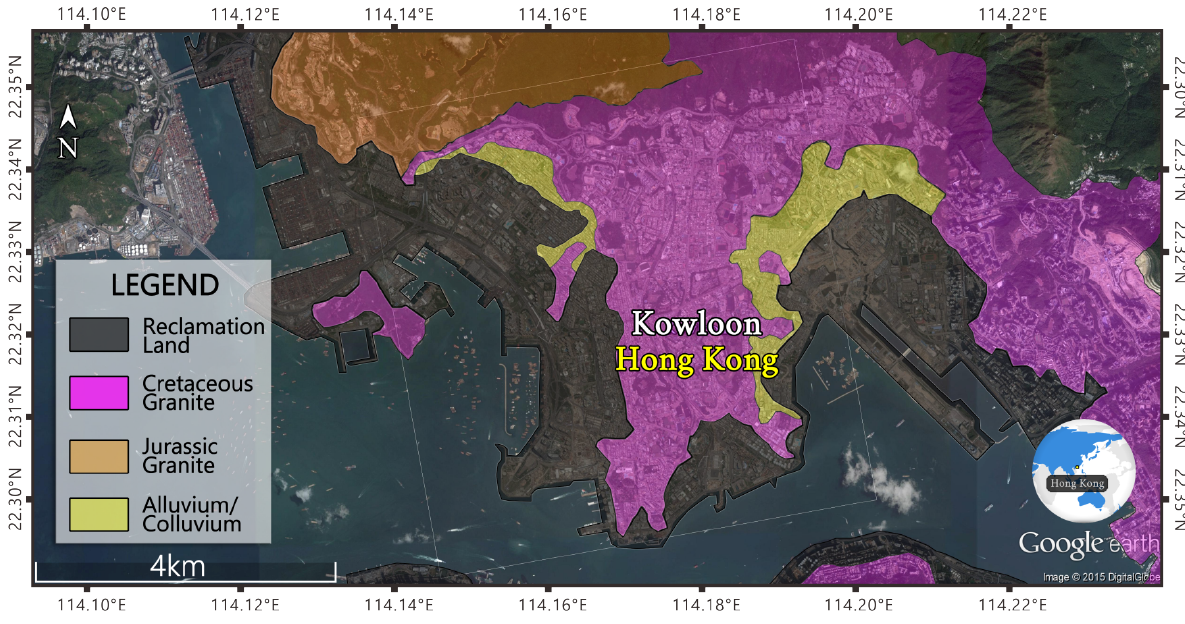
Figure 8. Geological map of the AOI. Granites, alluvium and reclamation land are the three main types of geological formations inside the AOI. Geological data are provided by Hong Kong Geological